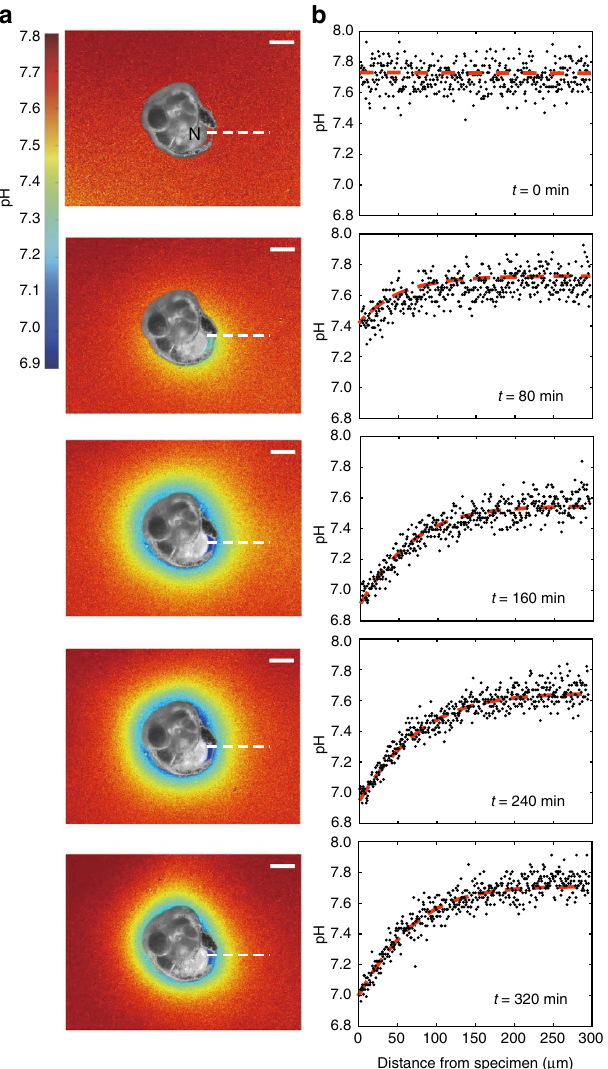
Figure 1 | Reduction in pH during foraminiferal calcification. Representative images showing the time-resolved decrease in pH of seawater surrounding a calcifying specimen of Ammonia sp. over a period of 320min. The pH values are imaged using dissolved HPTS and reported on the seawater scale. The incubated specimen shows ( a ) the two- dimensional variability in pH around the shell when building a new chamber and ( b ) the translated, spatially integrated change in pH versus distance from the foraminifer along the white dotted line shown in a . At the start of calcification, surrounding pH is still B 7.8 outside the foraminifer, decreasing to 6.9 after 4h and subsequently gradually increasing again 6h after the onset of calcification. It is noteworthy that minimum pH values are found closest to the newly precipitated chamber (N). In addition, a zone of reduced pH encloses the complete shell, also where no new chamber is being produced. The gradient in pH, increasing with distance from the specimen, is mainly caused by protons diffusing away from the site where the new calcite is precipitated. Scale bars, 100 m m. The false-colour scale bar represents pH. The b/w foraminifer is superimposed on false-colour pH